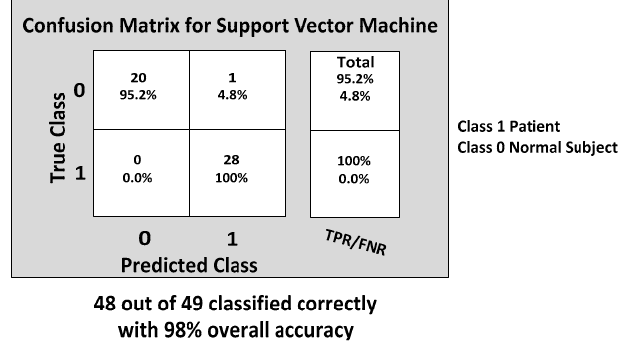
Figure 16. The final confusion matrix showing the gait classification results using the SVM classification